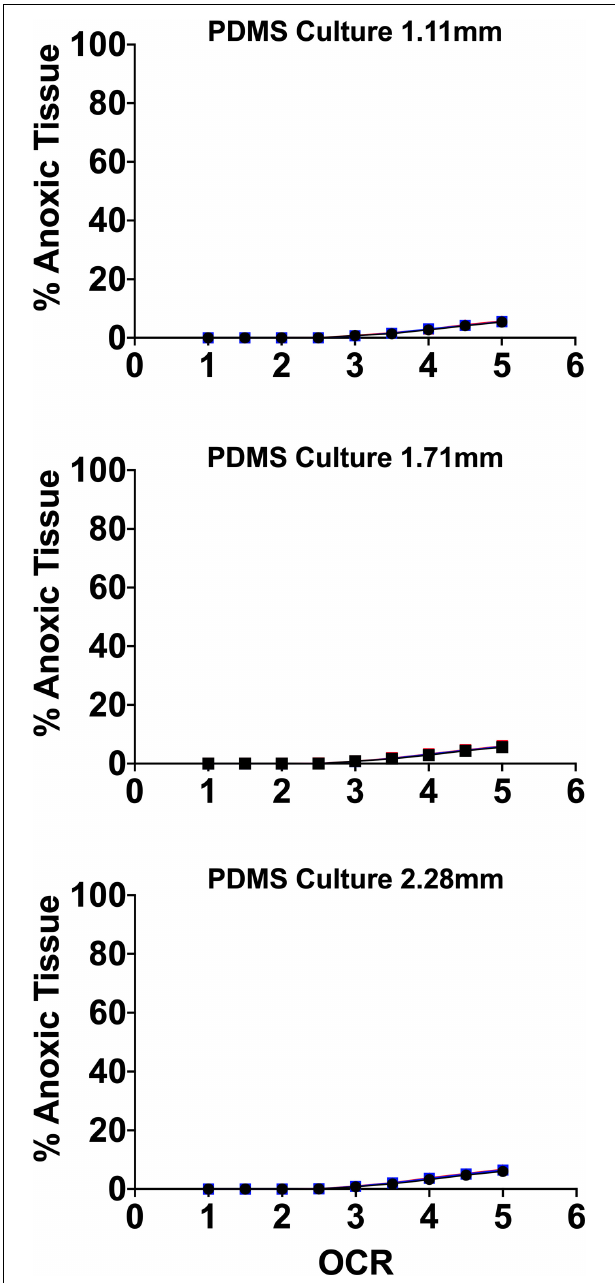
FIGURE 7 | Anoxic tissue volume percentages of endocrine spheroids (representative size range and OCR) cultured on perfluorosilane/PDMS constructs. Anoxia is eliminated in all but the largest aggregate size at the highest oxygen consumption rates. FEM was performed using three seeding densities (2.76–5.05%) and three culture medium heights (1.11, 1.71, and 2.28